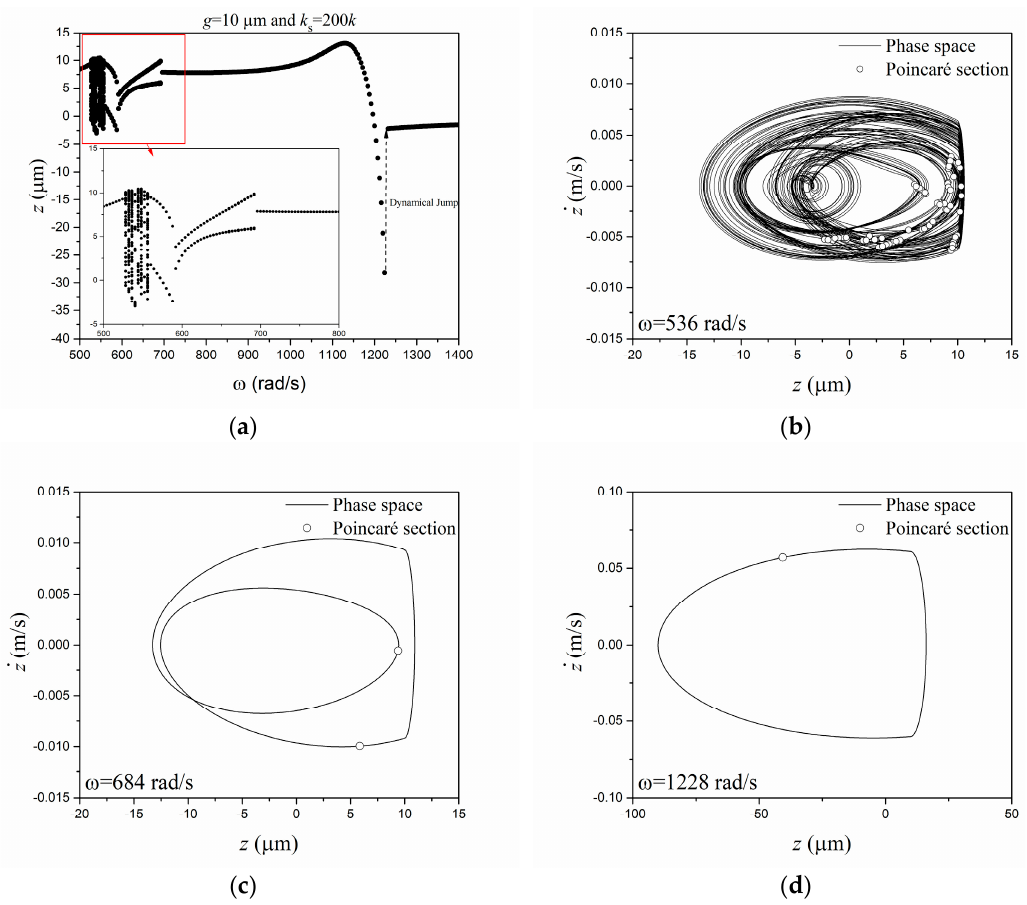
Figure 12. ( a ) Bifurcation diagram for g = 10 μ m and β = 200. Phase spaces and Poincaré sections for ( b ) ω = 536 rad/s, ( c ) ω = 684 rad/s, and ( d ) ω = 1228